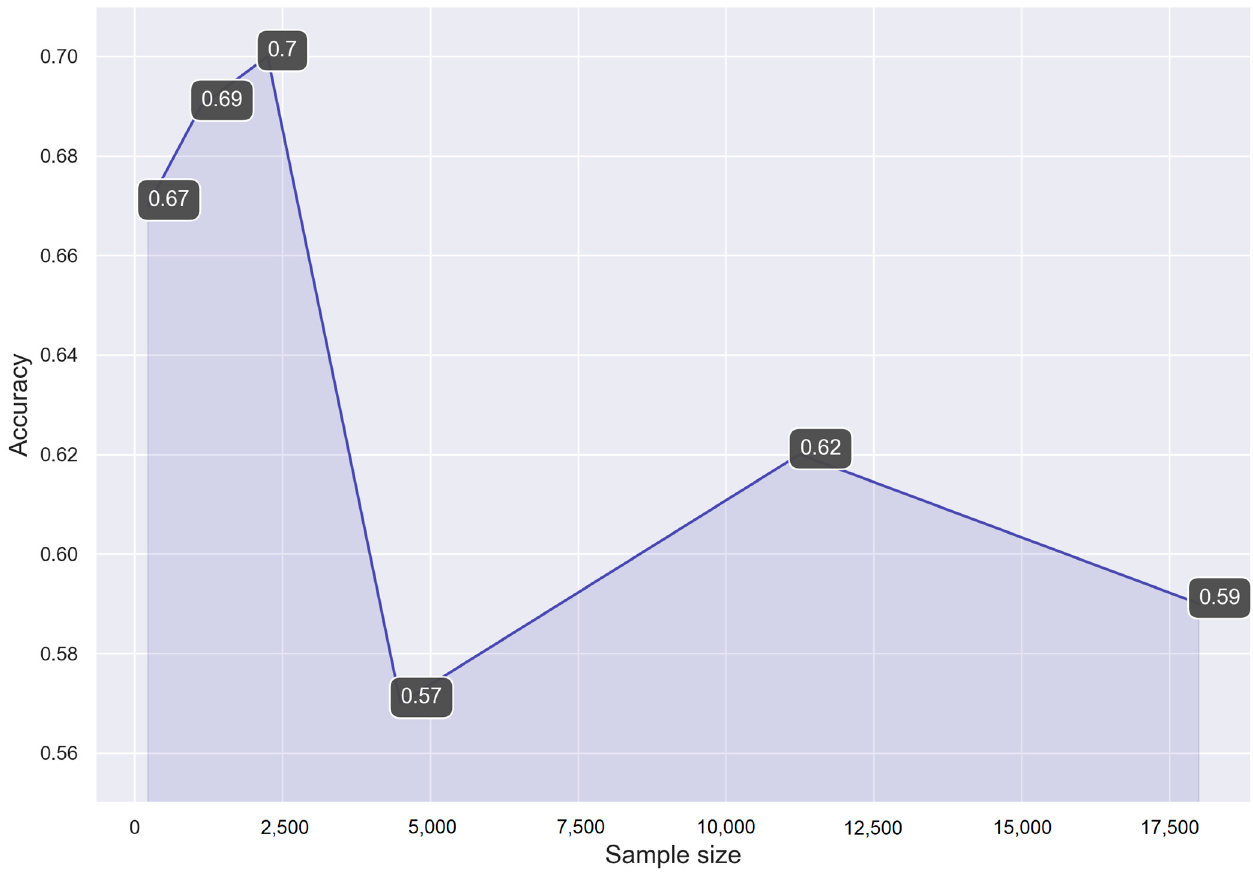
Figure 3. The dependence of forecasting accuracy on sample size.